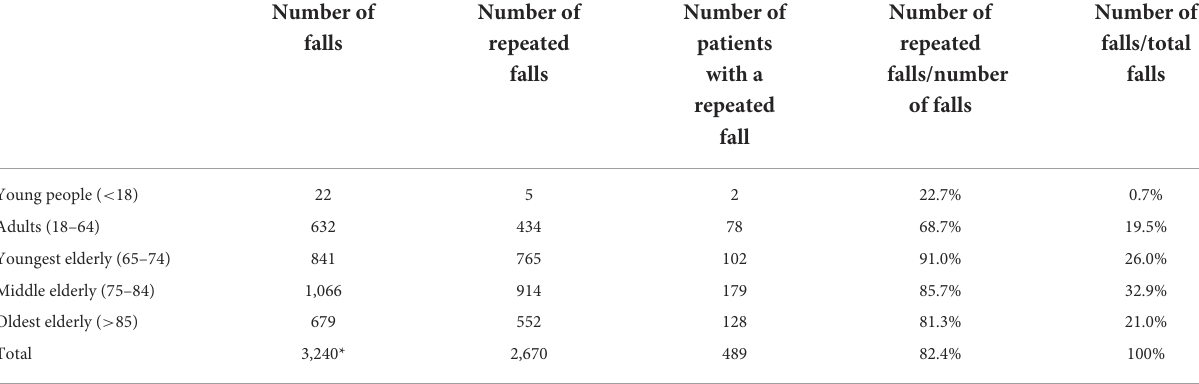
Number of falls